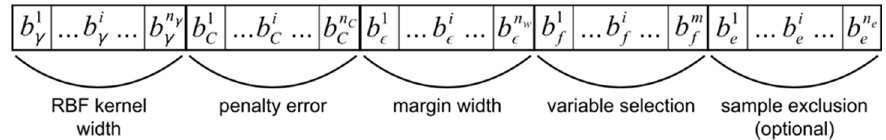
Figure 2. Genetic algorithm chromosome design. Bit string chromosomes are composed of segments encoding model parameter values, predictor variable selection, and training sample exclusion.